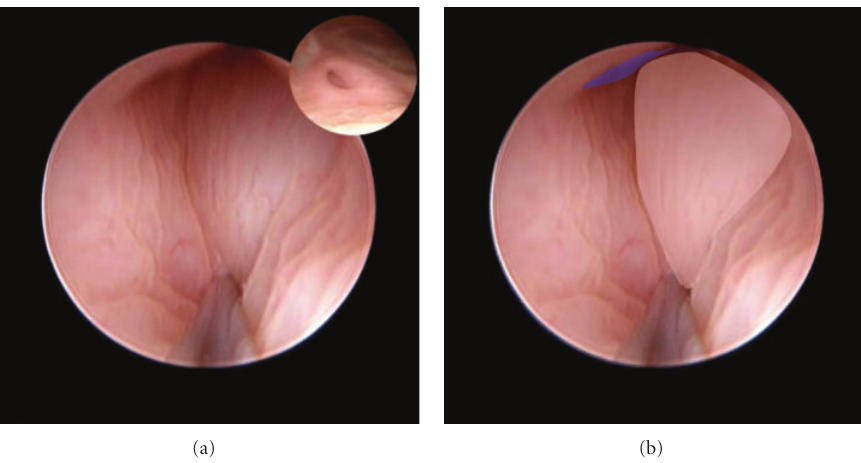
Figure 3: Procedure as CEVL components in a case of grade IV reflux in an infant girl. Mid-tunnel injection. Mid-tunnel injection is positioned as in Figure 2. The injection shown here has bulked the submucosa (overlay right). This component is complete as only a crescent of the ureteral lumen is still evident (blue